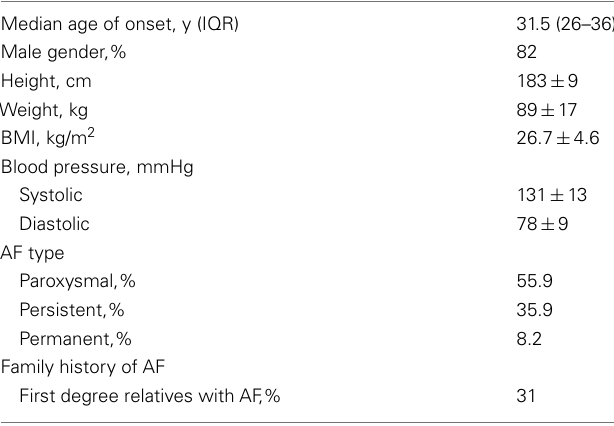
Table 1 | Clinical characteristics of the loneAF population ( n =